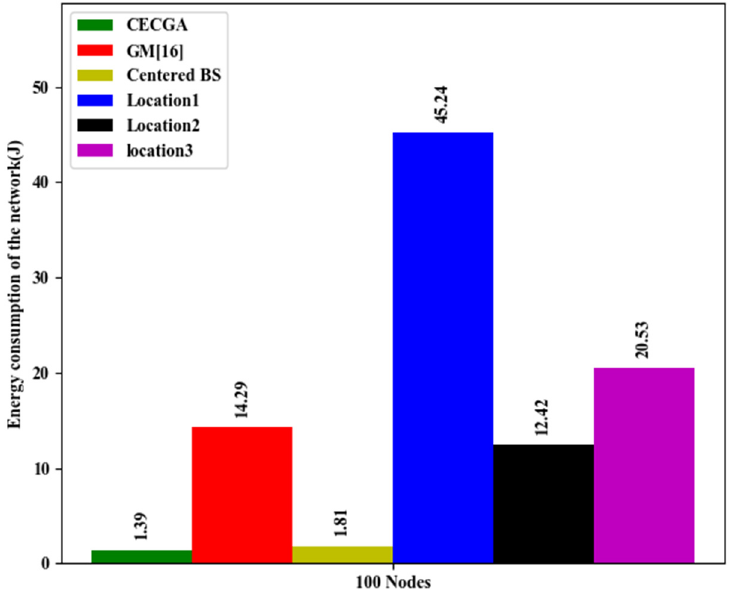
Figure 10. Energy consumption for different locations.